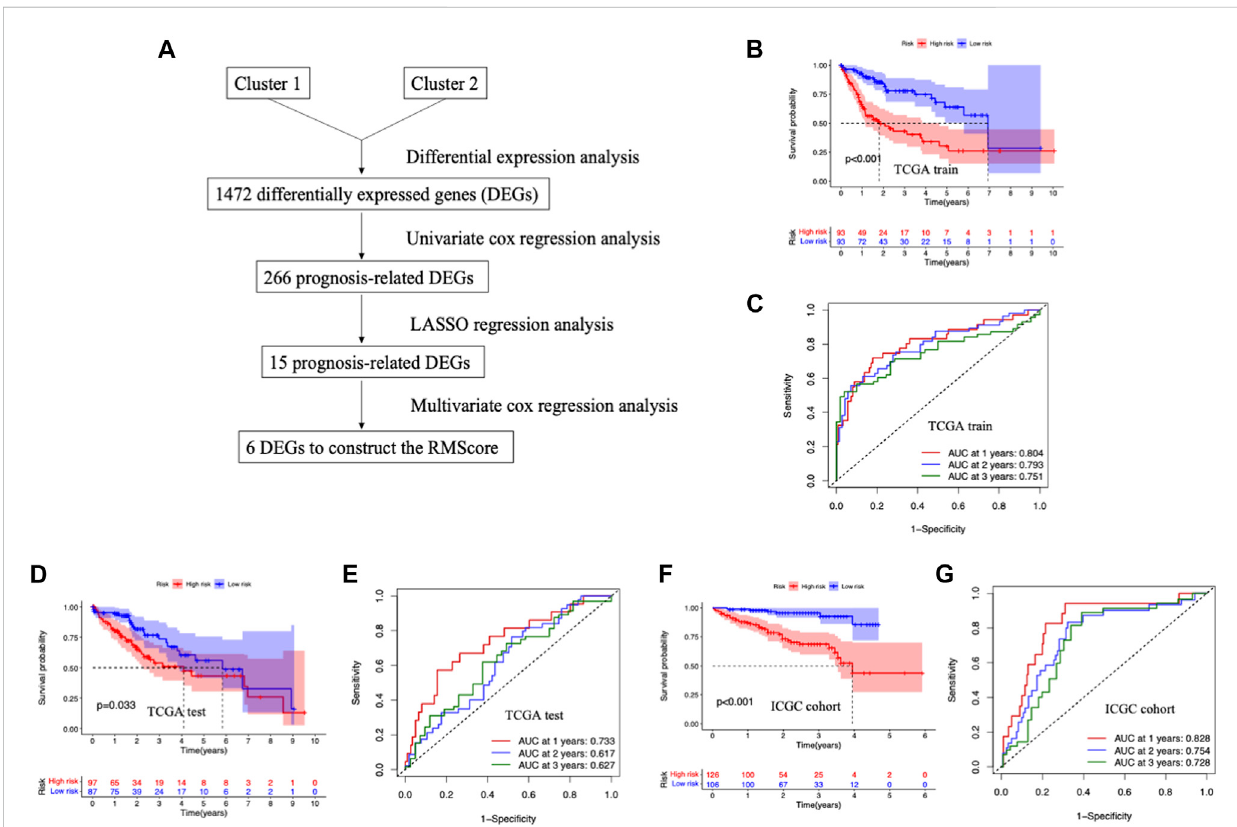
FIGURE 3 DevelopmentandvalidationofRNAmodi fi cationrelatedsignatureforHCC. (A) Thework fl owoftheconstructionoftheRMScore. (B) Survivalcurves strati fi ed by the RMScore in the TCGA training cohort. (C) Receiver operating characteristic (ROC) curves of RMScore for predicting survival in the TGGA trainingcohort. (D) Survivalcurvesstrati fi edbytheRMScoreintheTCGAvalidationcohort. (E) ROCcurvesofRMScoreforpredictingsurvivalintheTGGA validation cohort. (F) Survival curves strati fi ed by the RMScore in the ICGC cohort. (G) ROC curves of RMScore for predicting survival in the ICGC